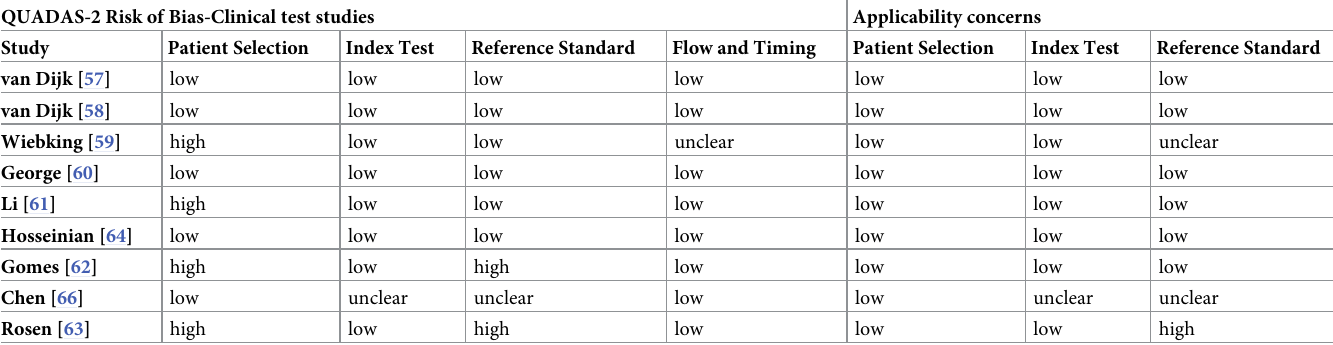
Plantarflexion and Dorsiflexion tests was insufficient (Kappa scores intra-rater: 0.27 to 0.70) or not calculated [47]. The novel ankle haptic interface system by Lin and colleagues [41] could be used to validly measure mobility (r: 0.99). Sensitivity and specificity values for Weight bear- ing lunge test, Ankle Plantarflexion, Inversion and Eversion were between 37.7 and 77.4 per- cent [38] (Table 6). Ankle strength. Testing ankle strength was evaluated only in the history of LAS popula- tion. The Baseline digital push-pull dynamometer for plantarflexion, dorsiflexion, inversion and eversion testing, showed specificity values between 50.7 and 86.8 percent. Sensitivity val- ues varied from 60.4 to 81.1 percent [38]. The isokinetic dynamometer could be used to reli- ably measure force for different angular velocities (120˚/s, 30˚/s) of inversion or eversion movement in individuals with a chronic condition following LAS (ICC: 0.71 to 0.95) [48] (Table 6). after the event showed improved sensitivity (acute: 71%; delayed: 96%) and specificity (acute: 33%, delayed: 84%) of the Anterior Drawer Test (ADT) in lying position [57–59]. However, when examined in seated position sensitivity (5 to 93%) and specificity values (67 to 100%) of ADT varied strongly [59–61]. Spahn [39] found a good correlation (r: 0.91) of clinical exami- nation with the ADT in lying examination position and the results of stress radiography. Stress sonography was still the most specific (specificity 87 to 100%) method for detecting injuries to the anterior talofibular ligament of the ankle joint compared to arthrometer and clinical exam- ination [59, 60]. Sonography showed insufficient values for inter-rater reliability (Kappa val- ues: 0.158 to 0.640) but was especially specific for the diagnostic testing (Specificity values: 76 to 99%) [64]. Moderate sensitivity values (44.70 to 50%) and high specificity values (97 to Table 3. Risk of bias rating